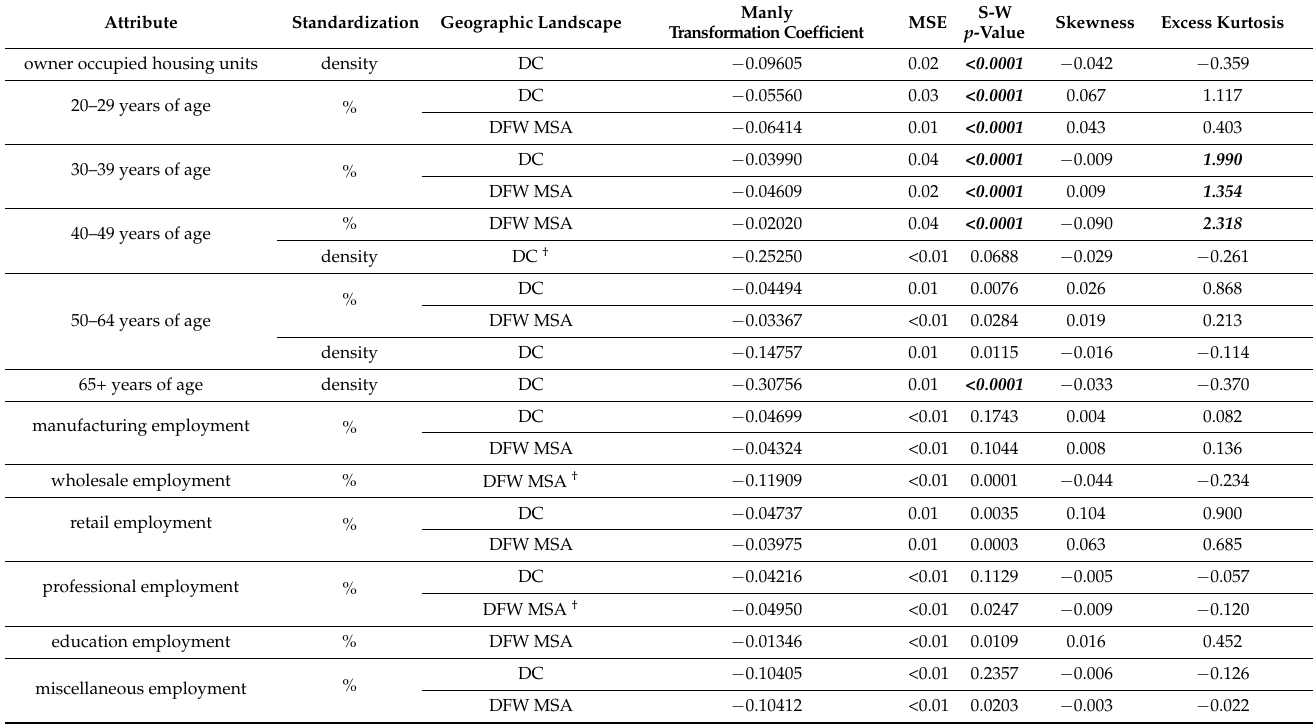
Table A1. Some relevant facets of reciprocal Manly exponential data transformation oriented at- tribute